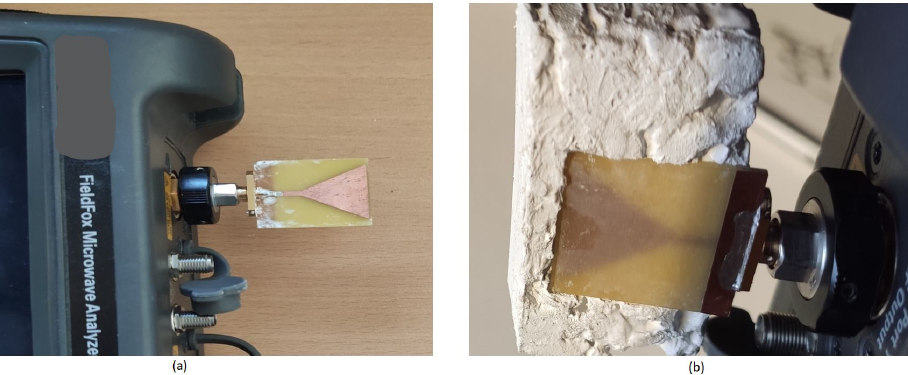
Figure 8. ( a ) The antenna is not covered by the matching medium. ( b ) The antenna is covered by the matching medium. The antenna is directly connected to the VNA in both